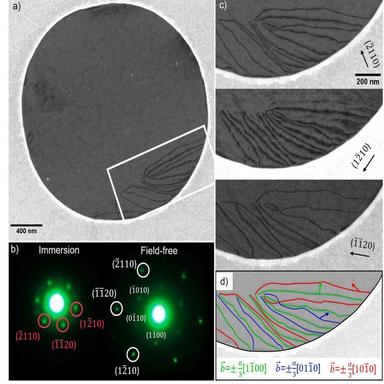
Burgers vector analysis of basal plane dislocations in bilayer graphene using the aperture-based dark-field STEM method in SEM. a, b) Overview image of bilayer graphene sample (a) and corresponding transmission diffraction patterns recorded in immersion and field free mode (b). c) Three dark-field images taken with the indicated Bragg reflections of type . d) RGB color representation of the dislocations and their Burgers vectors (see text for details).